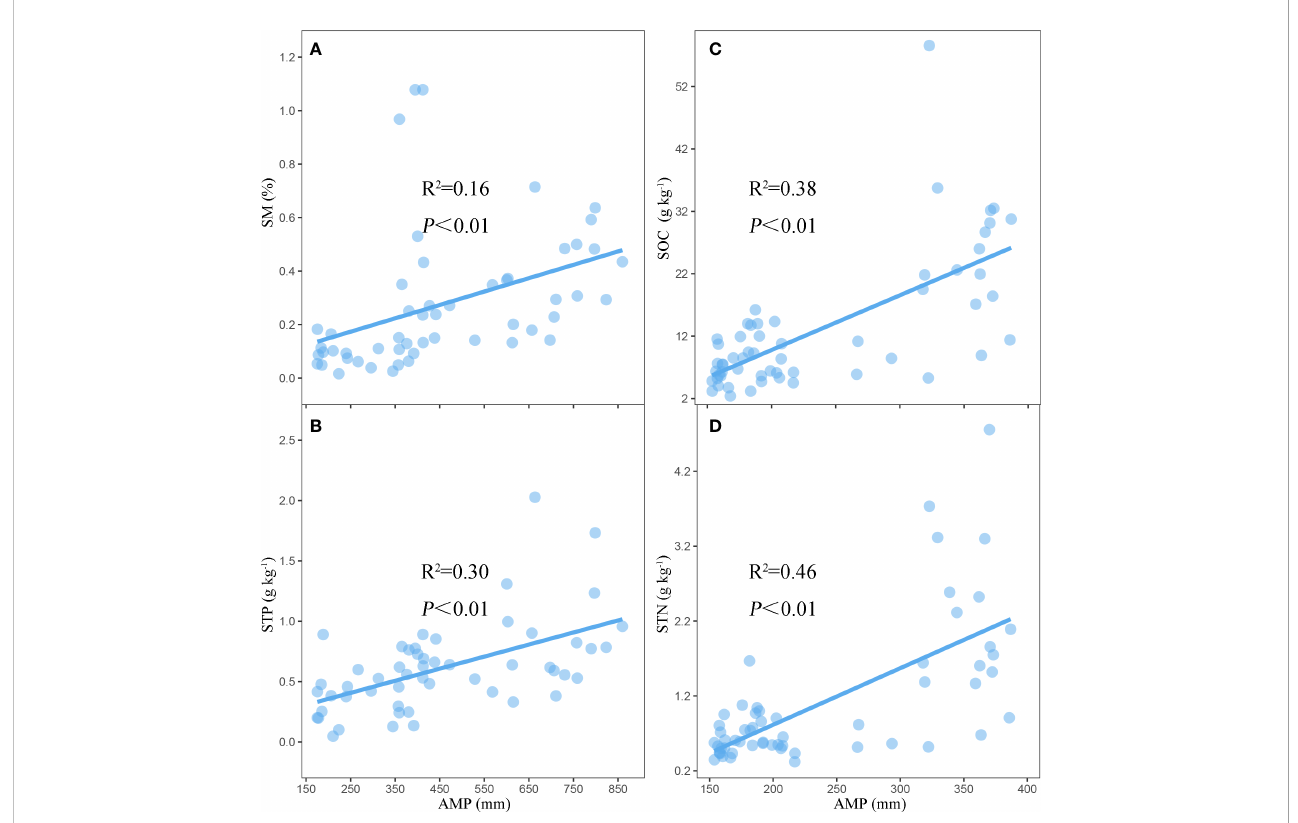
FIGURE 7 The linear fi ts of AMP to (A) SM and (B) STP in AM and SOC (C) and STN (D) in AS. SM, soil moisture; STP, soil total phosphorus; SOC, soil organic carbon; STN, soil total nitrogen.